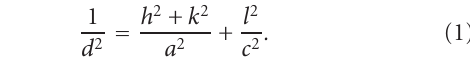
Figure 2: SEM micrographs of the powders synthesized with molar ratios of CMC monomer to metal ions to (a) 0:1, (b) 0.1:1, and (c) 0.3: